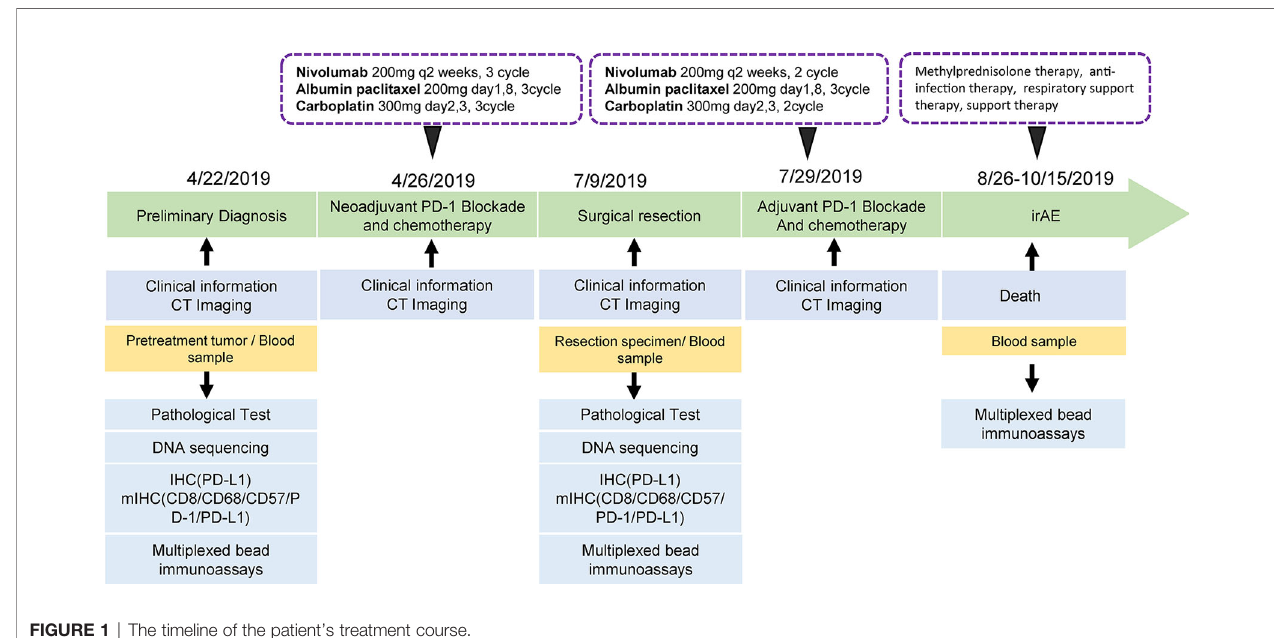
FIGURE 1 | The timeline of the patient ’ s treatment course.